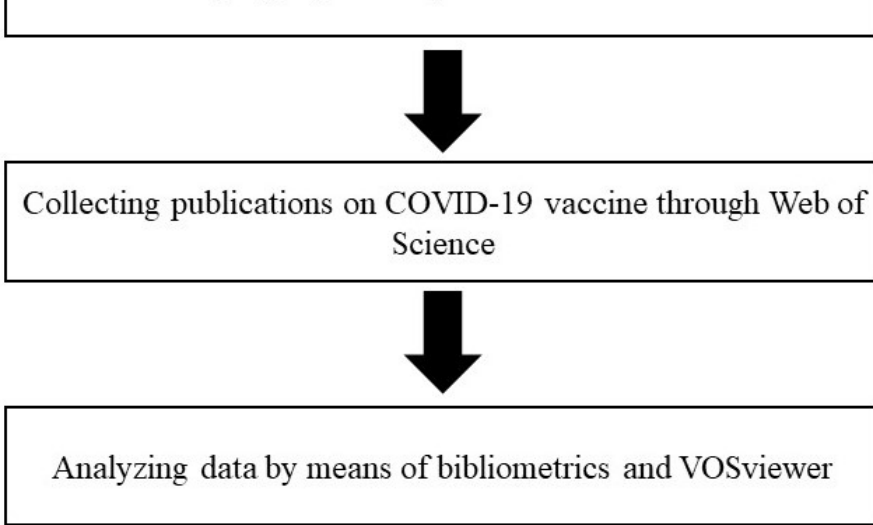
Figure 2. The research procedure in this study.